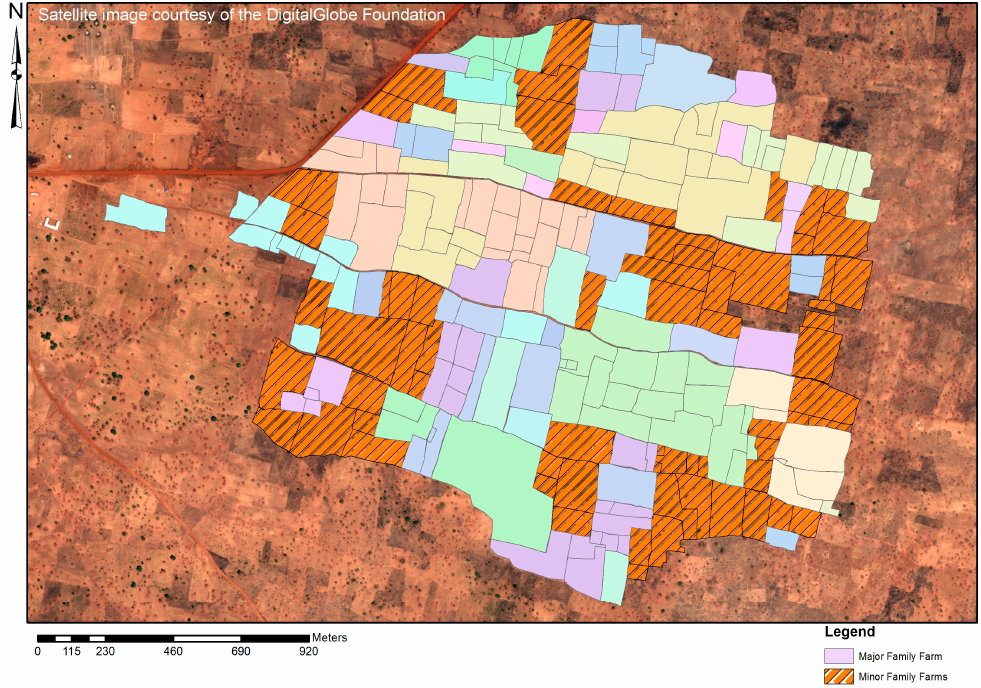
Figure 5. Family Lands in the Area of Interest (Sub-Allodial Interest as family farms and divisions into Customary Freehold as Individual Farms). Table 2. Summary of Data Collected.